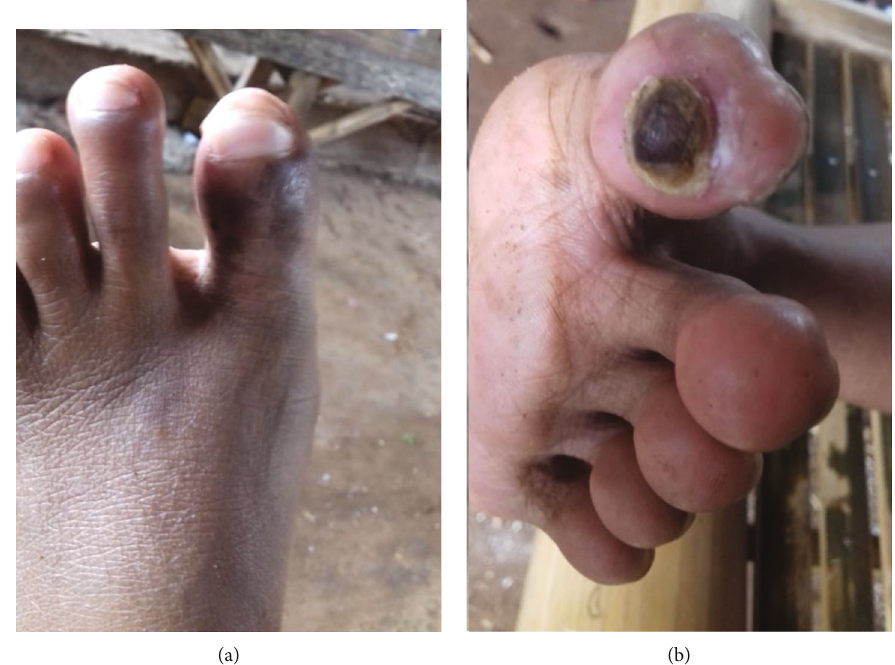
Figure 3: Image of dorsal (a) and ventral (b) views of the left foot in the six-month follow-up, with signi fi cant clearing of cyanotic